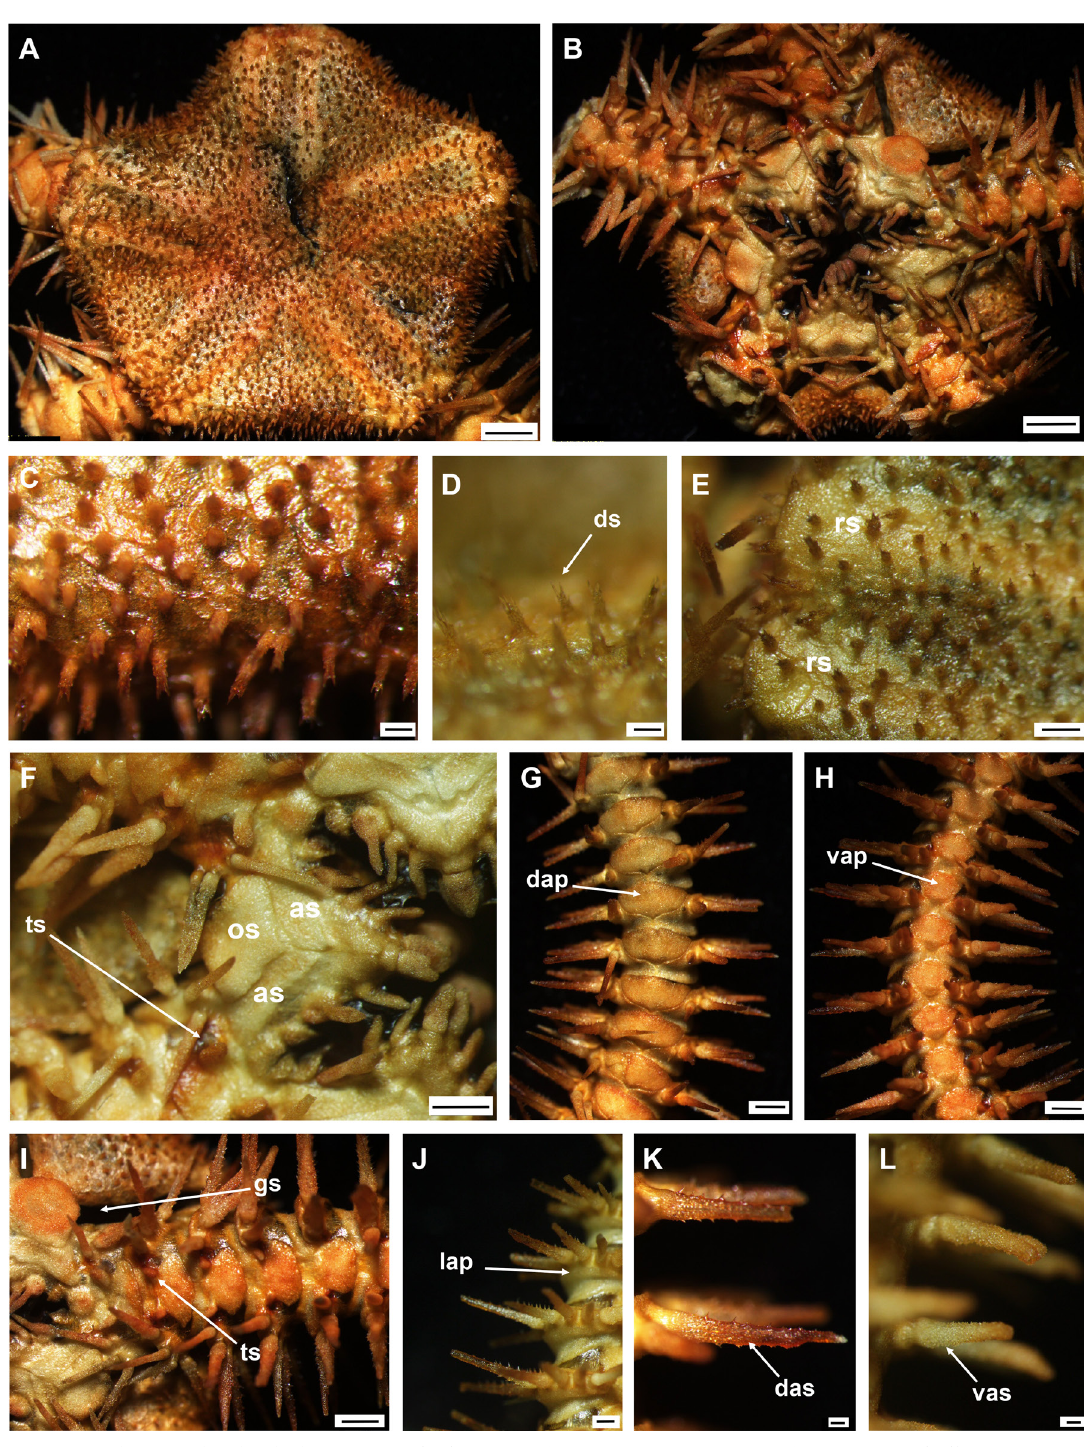
Fig. 27. Ophiacantha bathybia H.L. Clark, 1911 (IDSSE EEB-SW0025). A . Dorsal disc. B . Ventral disc. C–E . Different angles of disc spines on dorsal and ventral disc. F . Oral frame. G . Dorsal arm. H . Ventral arm. I . Ventral arm base. J . Arm spine structure in lateral plate. K . Dorsal arm spine. L . Ventralmost arm spine. Abbreviations: as = adoral shield; dap = dorsal arm plate; das = dorsal arm spine; ds = disc spine; gs = genital slit; lap = lateral arm plate; os = oral shield; rs = radial shield; ts = tentacle scale; vap = ventral arm plate; vas = ventral arm spine. Scale bars: A–B = 2 mm; C–F = 1 mm; G, L = 500 µm; H–K = 200